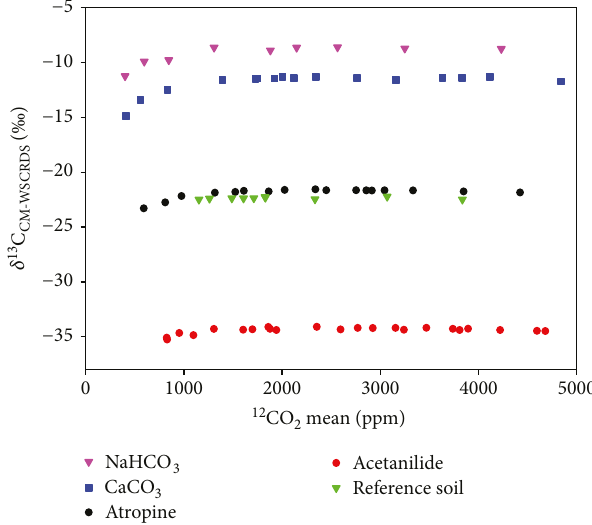
Figure 5: C content-dependent measurements of δ 13 C values determined by the